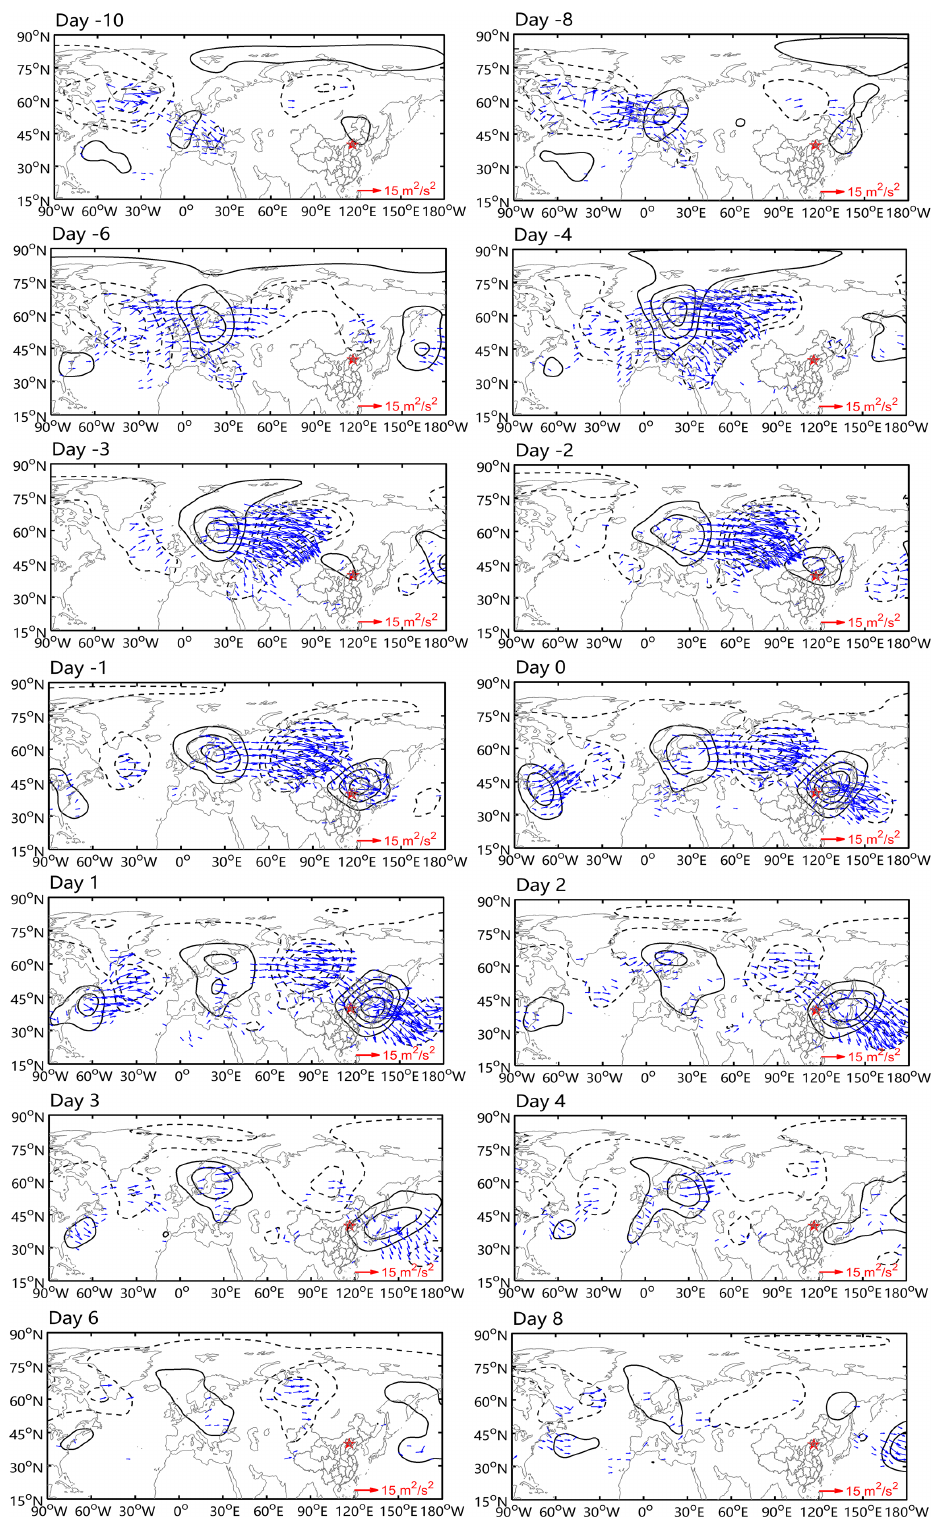
Figure 3. Instantaneous fields of the composite daily Z500 anomalies (contours, interval = 20; units: gpm) and horizontal components of wave activity developed by Takaya and Nakamura (2001) (arrows; units: m 2 s − 2 ) from Day − 10 to Day 8 for the 65 persistent haze